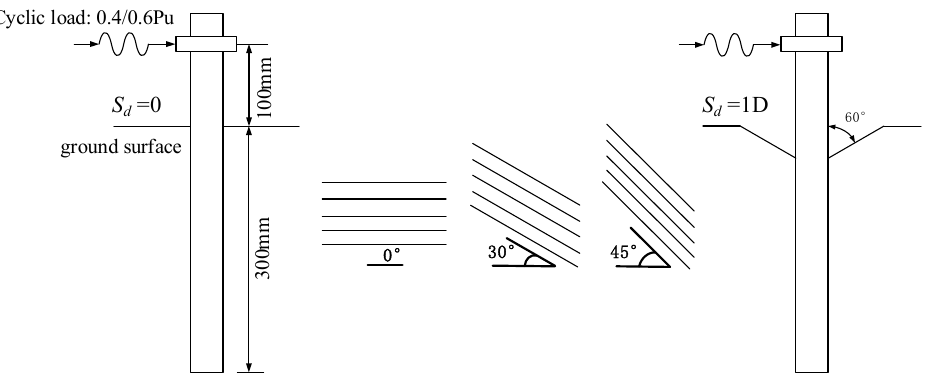
Figure 9. Illustration of the test program.